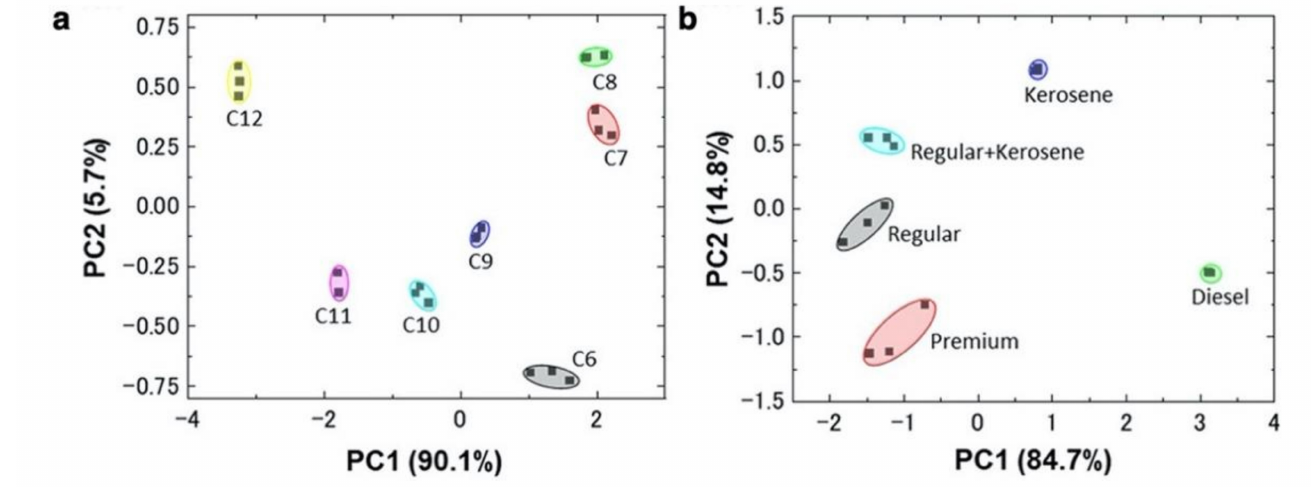
Figure 13. Identification of fuel oils by MSS through PCA. ( a ) PCA scatter plot of the identification of linear aliphatic hydrocarbons. ( b ) PCA scatter plot of the identification of fuel oils through their vapors. Reprinted from [145], the authors licensed under CC-BY-NC-ND 4.0.